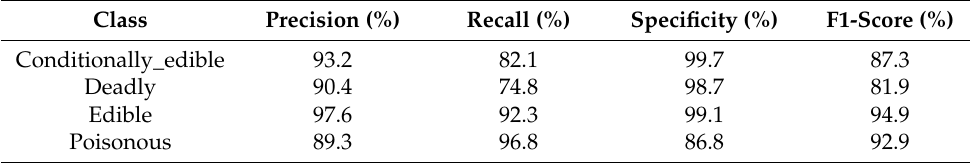
Table 2. Classification evaluation results of M-ViT on the mushroom